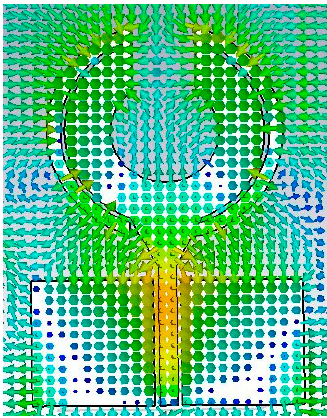
Figure 8. Electric field distribution of the proposed patch antenna at 3.5 GHz.